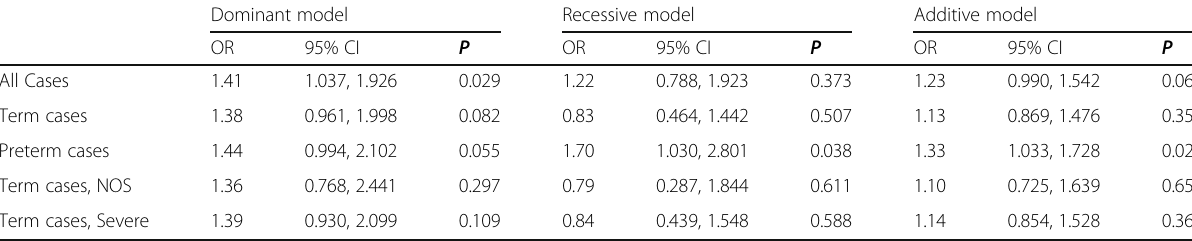
Table 3 PE association with fetal APOL1 genotype: Unadjusted model Dominant